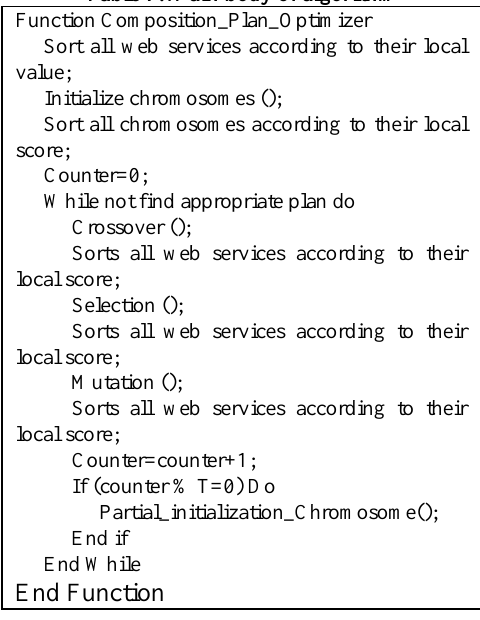
Table 7. Main body of algorithm